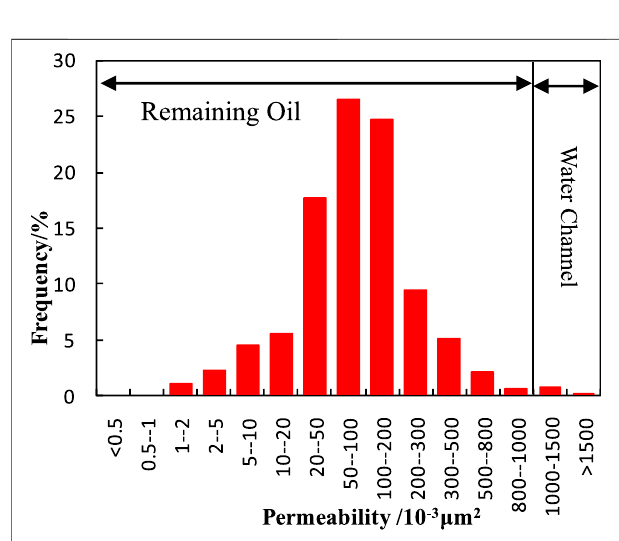
FIGURE 2 | The statistical analysis of the permeability distribution.